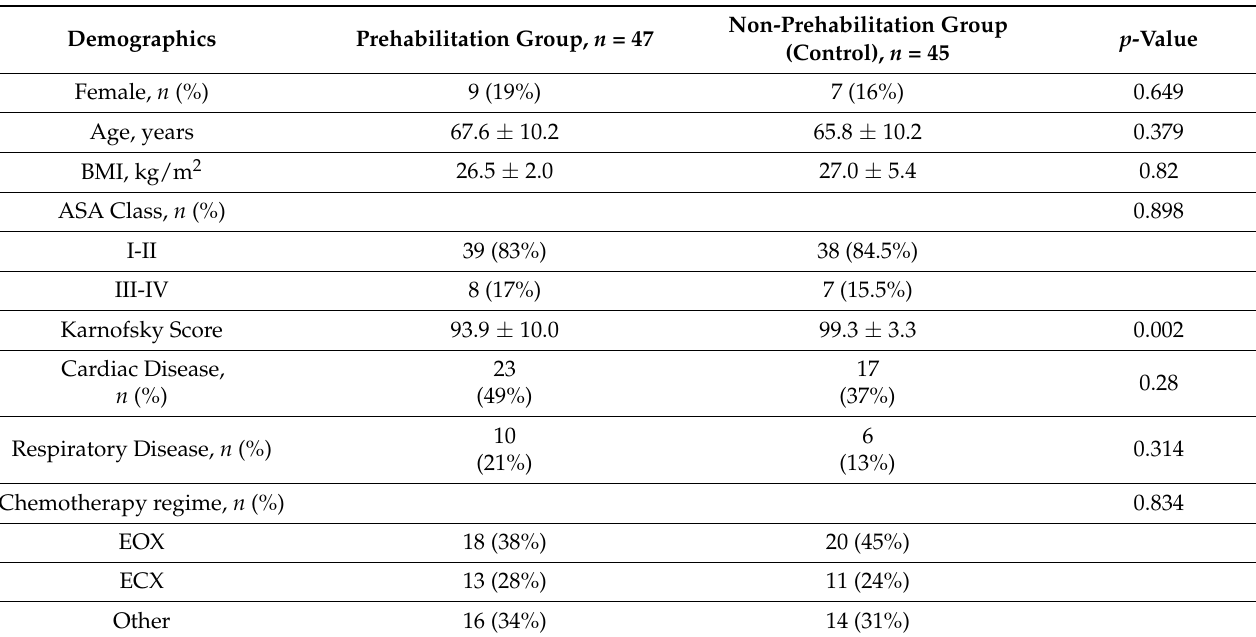
Table 1. Patient baseline characteristics.